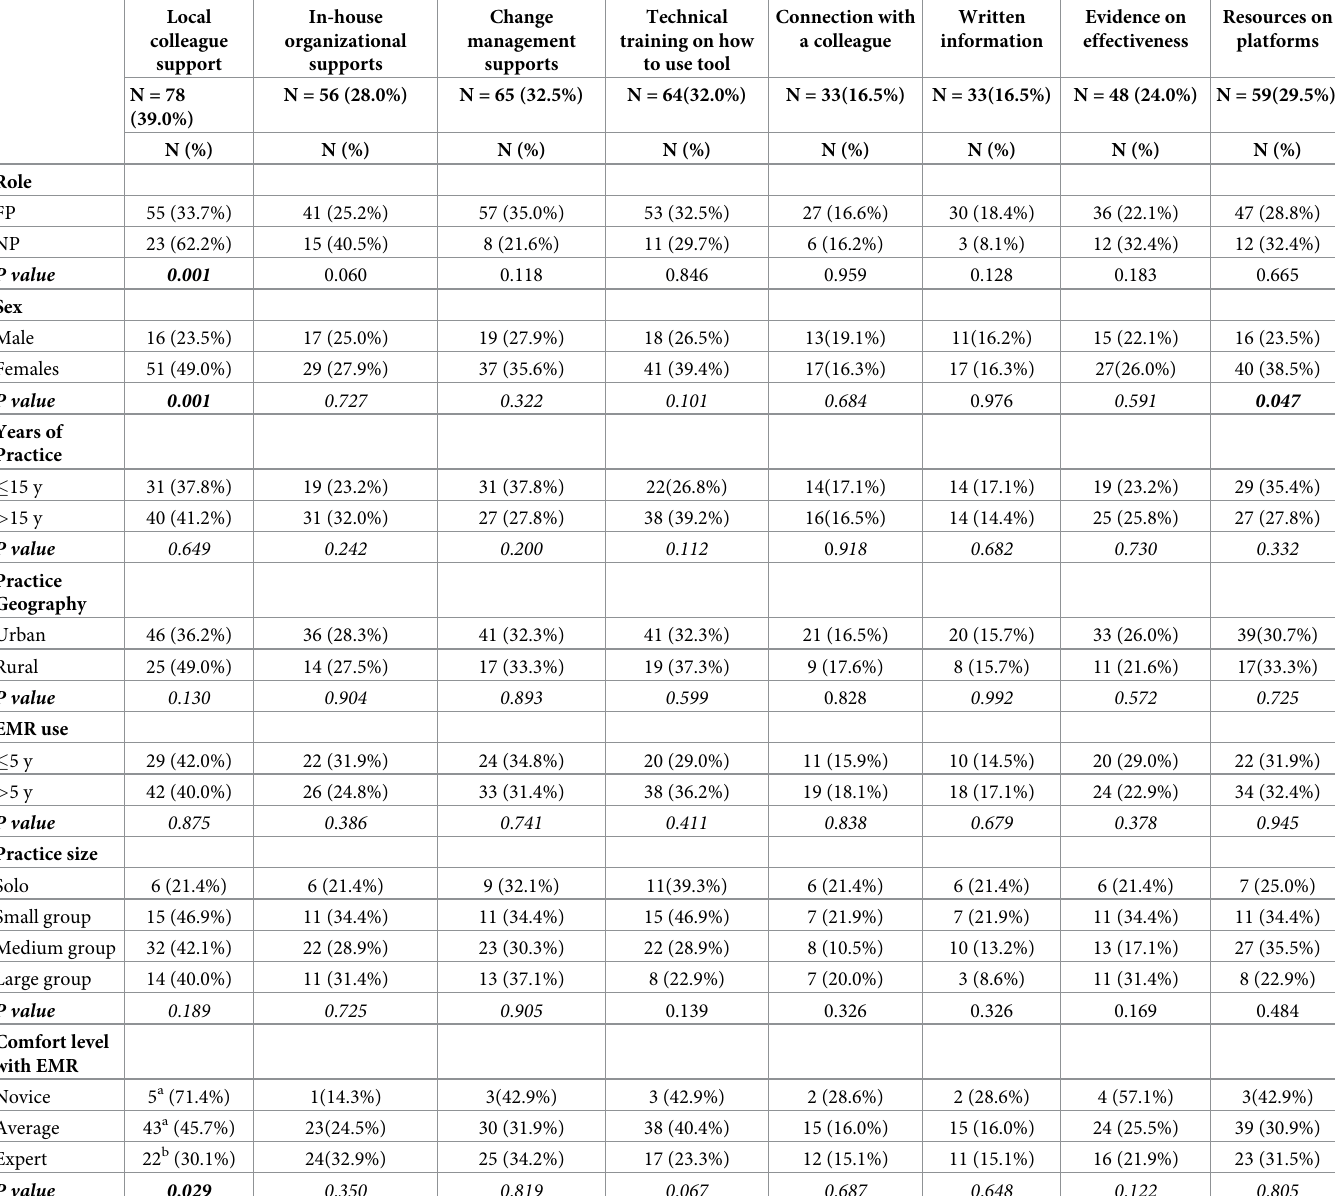
Table 5. Useful support tools and resources to offereing virtual visits by the characteristics of